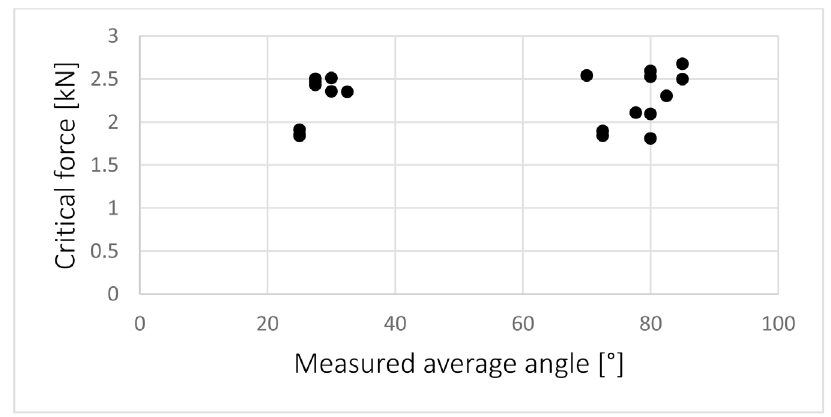
Fig. 5. Critical load as a function of the measured average angle of the wood fi